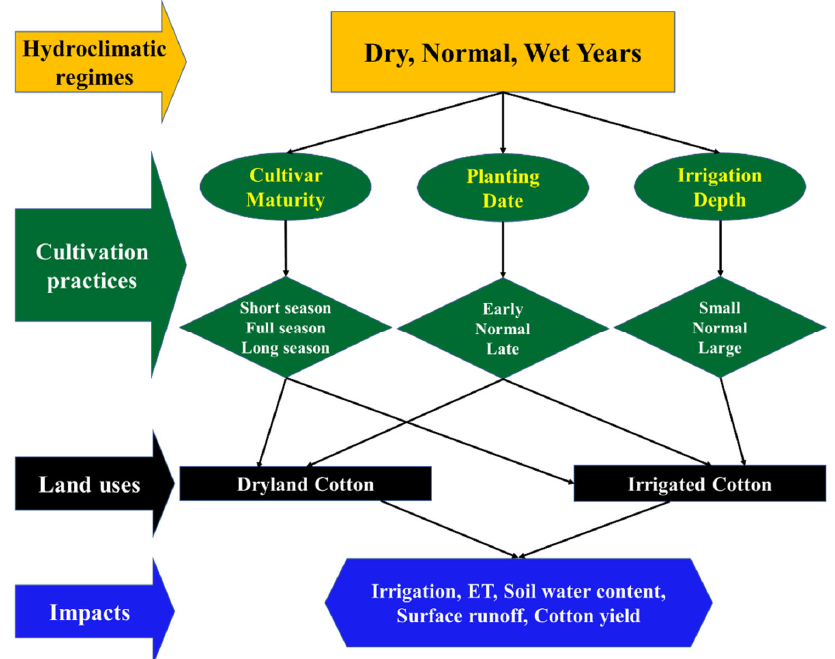
Figure 2. Flowchart of the modeled cultivation practices in the Texas Panhandle.